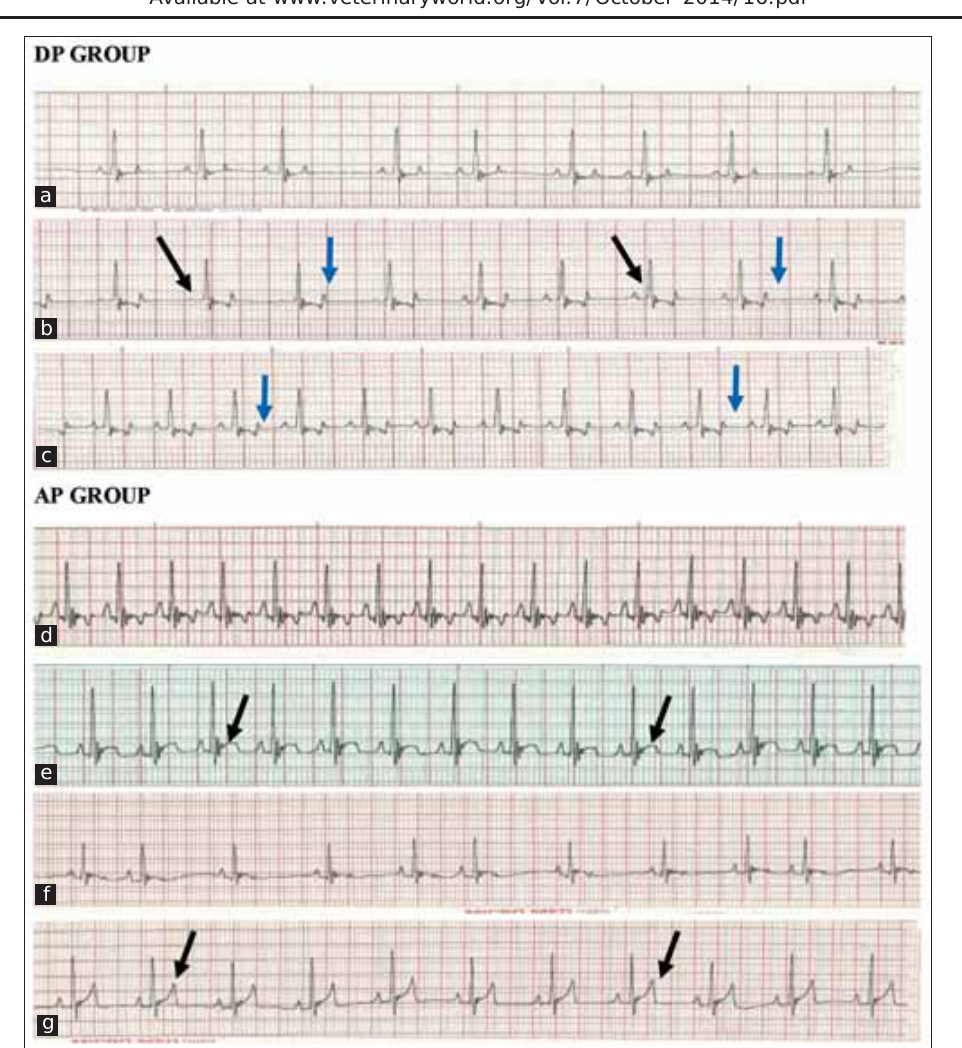
Figure-1: Electrocardiographic findings, (a) At T wandering sinus pacemaker (black arrows) is evident and diphasic T waves (blue arrows), (c) At T sinus pacemaker and diphasic T waves are still presented, (d) Normal ST segment at T was observed (black arrows), (f) At